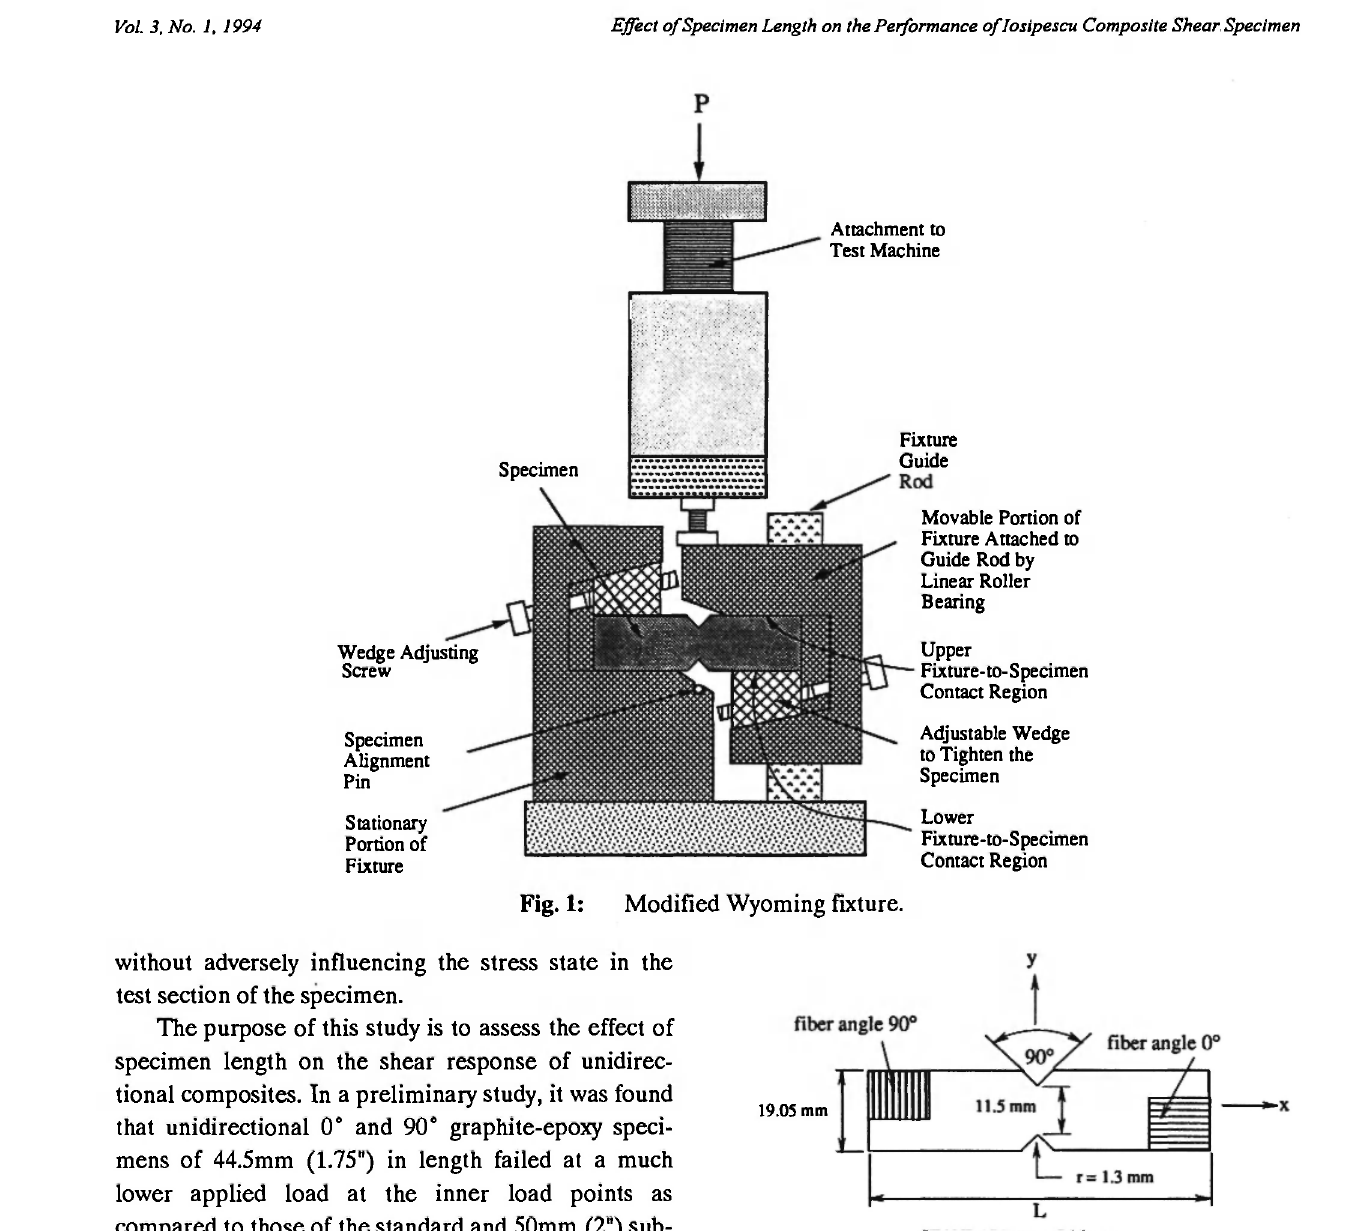
iosipescu V-notched